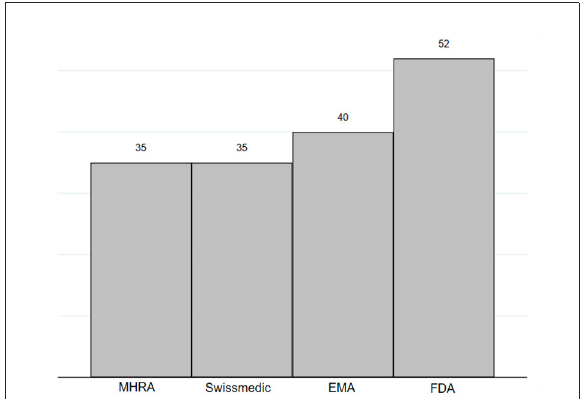
FIGURE1 Number of novel medicines authorized in 2021 by MHRA, EMA, FDA and Swissmedic. Novel medicines were defined as medicines with new active substance ( n = 97). In this figure displays data published by FDA on New chemical entity (NCE) and Biologics License Applications (BLA), by EMA on New Active Substance (NAS), and by Swissmedic on authorized human medicines with new active substances (29–32). MHRA does not publish similar data and new active substance status was assessed on the basis of the assessment report by study authors (28, 33). Figures were adjusted to exclude diagnostics, vaccines including COVID-19 vaccines, COVID-19 therapeutics, diagnostics, source plasma products, and medicinal products that were associated with negative appraisals/withdrawals, generic approvals, or reference approvals for other